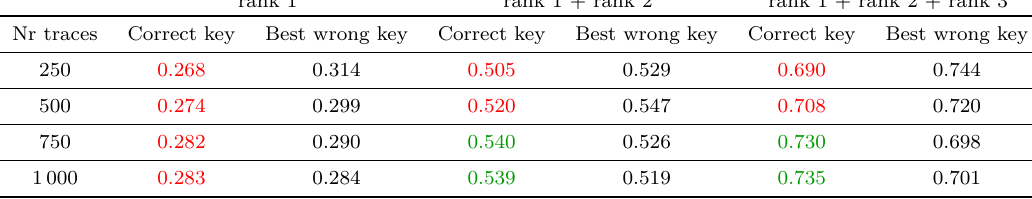
Table 6: Density for class probability ranks 1, 2, and 3 for the ASCAD dataset in the Hamming weight model ( best wrong key selected from rank 1 only.